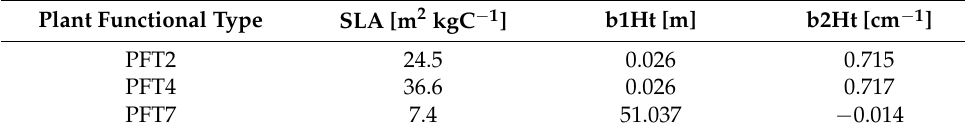
SLA: specific leaf area; b1Ht: height allometric intercept; b2Ht: height allometric slope. After calibration, the RMSE and MAE of the corrected DBH-height allometry for PFT2 decreased by 34.7% and 57.4% compared with the default allometry, respectively. The RMSE and MAE of the corrected DBH-height allometry for PFT4 decreased by 35.8% and 58.8% compared with the default allometry, respectively (Table